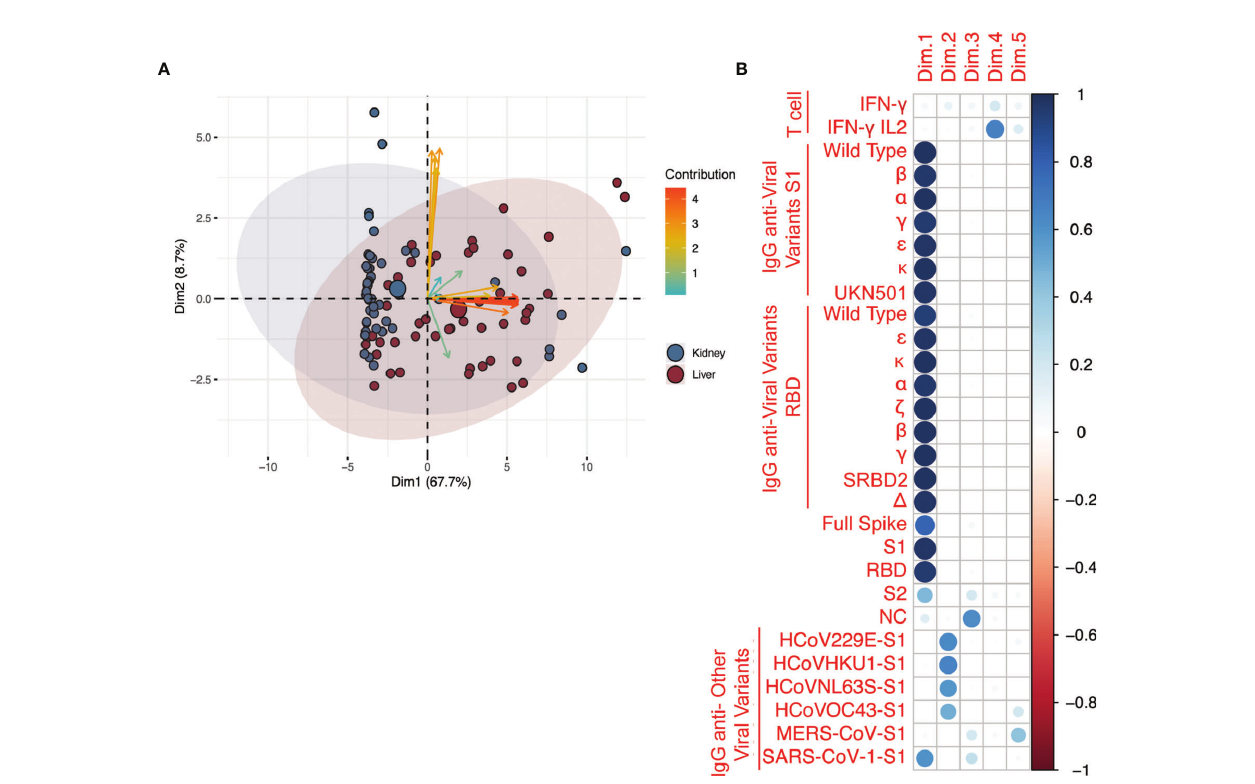
FIGURE 1 | Principal component analysis (PCA) of all the assays after second vaccination. (A) Analysis included antibodies against anti-SARS-CoV-2, anti-SARS- CoV-2 variants, and common coronaviruses, and IFN- g and IL-2 T cell responses. The axes represent the two variables, among all those generated by PCA, that ranked fi rst in terms of proportion of assay variability. The variables are represented by arrows; blue arrows = Fluorospot assays, orange arrows = anti-SARS-CoV-2 serological assays, yellow = serological assays for other coronaviruses. The angle between arrows represents the correlation between assays: assays with the same direction have a correlation coef fi cient of 1, those with opposite directions have a correlation coef fi cient of -1. Those that are perpendicular to each other have a correlation coef fi cient of 0. The patients are represented by data points with individual point size proportional to the quality of representation in the bi-dimensional plot. The plot is based on data after two vaccinations only (T2). The categorical variable type-of-solid-organ-transplantation (i.e. kidney vs liver) is added to the plot as a supplementary variable to visualize how the pattern of correlated variables and cloud of data points are distributed between types of solid organ transplantation. The colored ellipses represent the 95% con fi dence ellipses of the scatter around overall assay mean of each group (liver = blue or kidney = red). (B) Correlation between the fi ve principal components extracted from PCA and the original variables (assays: T cell reactivity and IgG against SARS-CoV2 antigens and variants and other coronaviruses, including common coronaviruses: HCoV229E-S1, HCoVHKU1-S1, HCoVNL63S-S1, HCoVOC43-S1). As shown by the legend in the rightmost column, the correlation is represented by a color gradient as follows: blue for positive correlation, red for negative correlation, and white for no correlation. The correlation coef fi cient is represented by a circle, the diameter of which is proportional to the strength of the correlation. The variability explained by the principal components Dim.1 to Dim.5 was 67.7, 8.7, 5.6, 3.8, and 3.5%, respectively (not